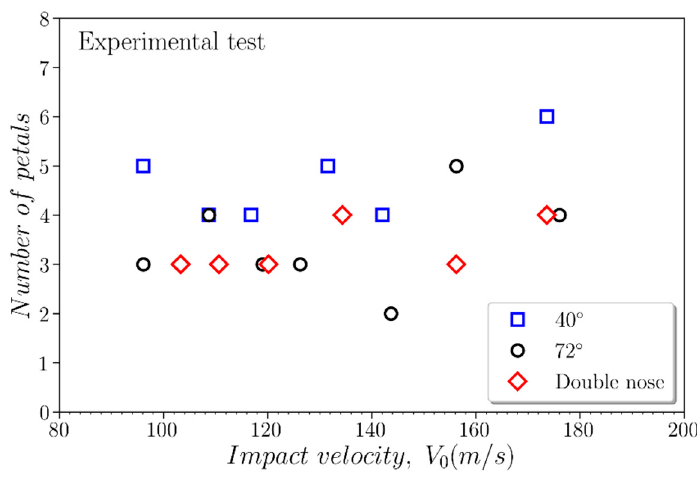
Figure 11. Number of petals as a function of the impact velocity for 40° conical projectile, 72° conical projectile, and double-nose